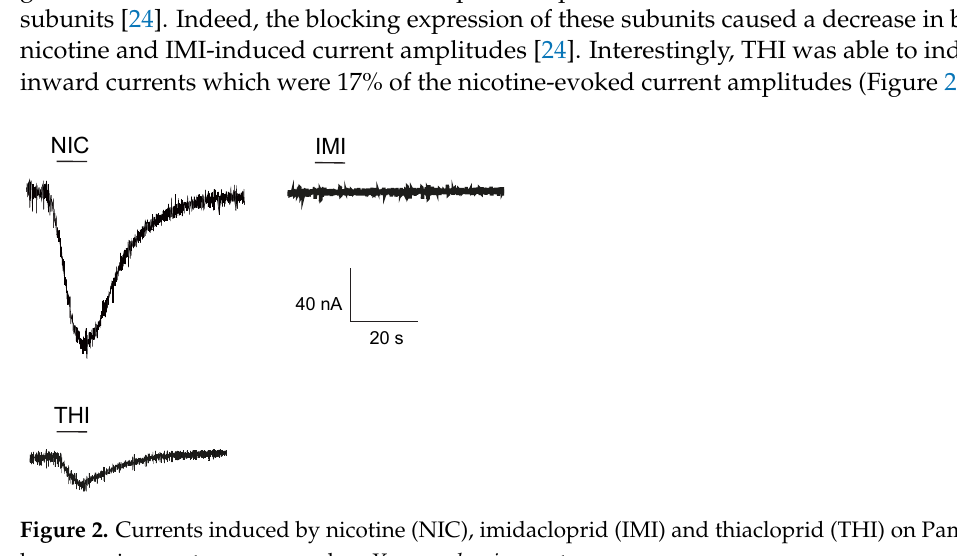
Figure 1. Chemical structures of the neonicotinoids, imidacloprid ( left ) and thiacloprid ( right ).